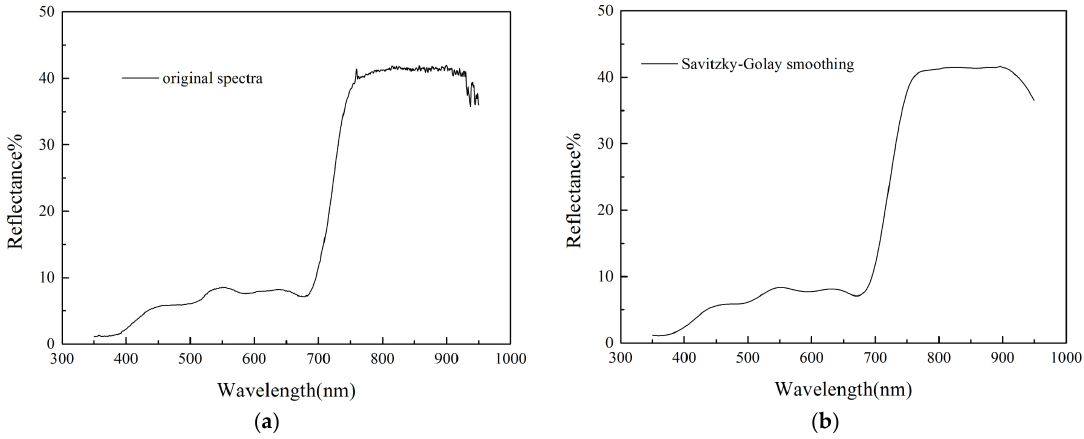
Figure 4. Spectral curve smoothing based on the Savitzky–Golay approach. ( a ) Original spectral curve; ( b ) smoothed spectral curve.